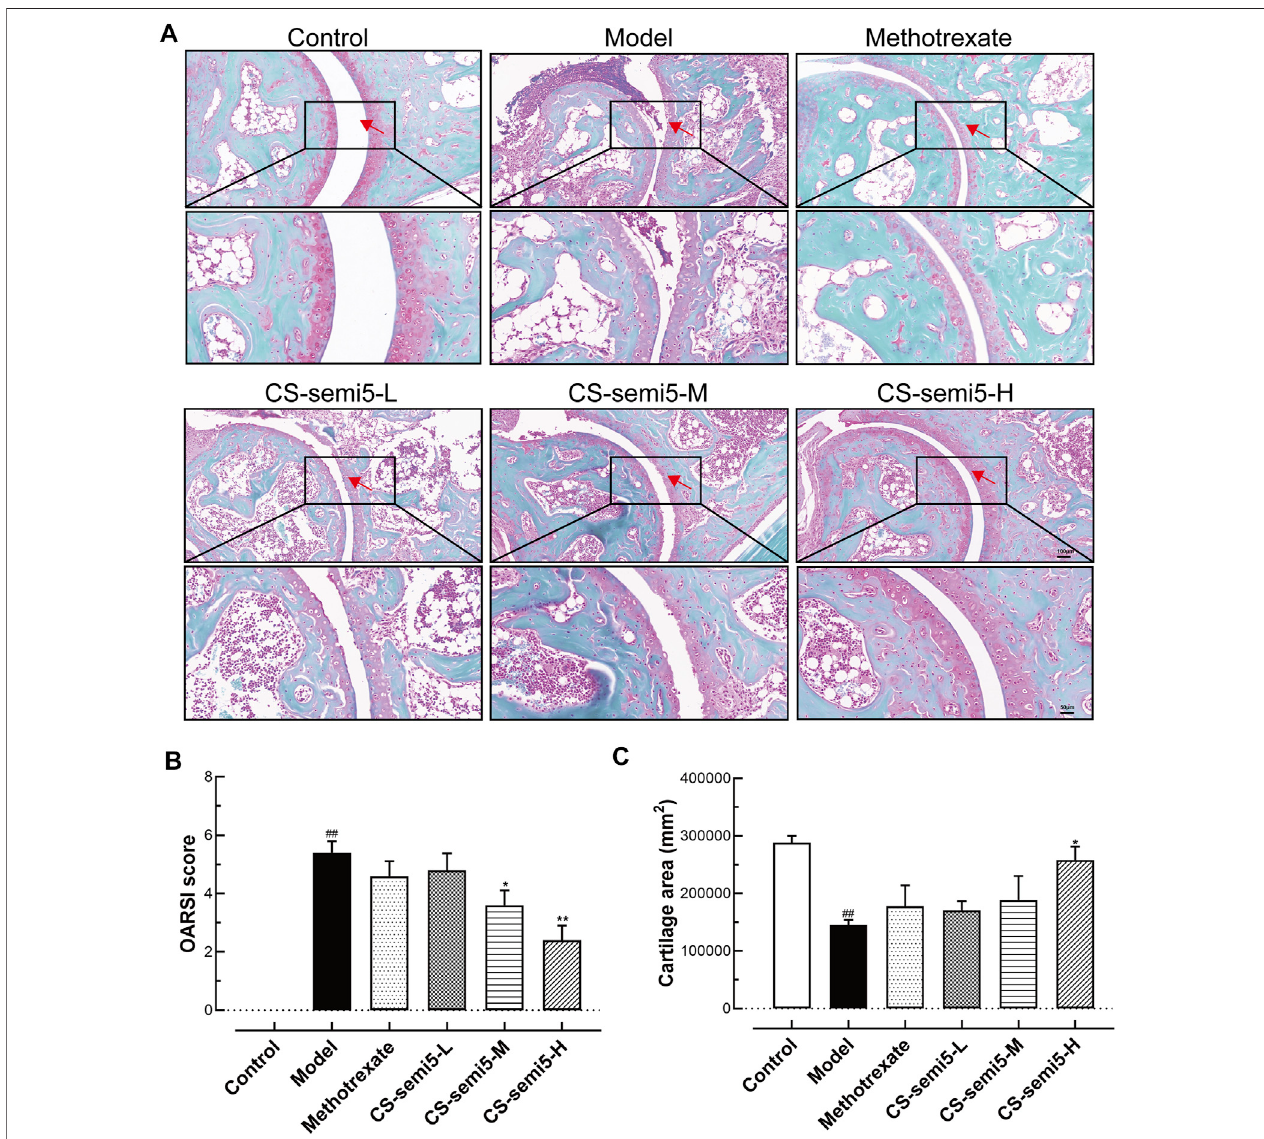
FIGURE3| CS-semi5alleviatescollagen-inducedcartilagethicknessreductionandcartilagelossinCIAmice. (A) SafraninO/fastgreenstainingofanklejoints.Red arrows indicate cartilage. Original magni fi cation was 100 × , and 200 × magni fi cation was used in high-power views. Bar respectively indicates 100 and 50 μ m. (B) The severityofcartilagelosswasanalyzedbasedontheOARSIscoresystem. (C) Articularcartilageareaswerequanti fi edbytracingSafraninO-positivestainedareas. n (cid:1) 7. ## p < 0.01 compared with Control group; * p < 0.05 and ** p < 0.01 compared with Model group.